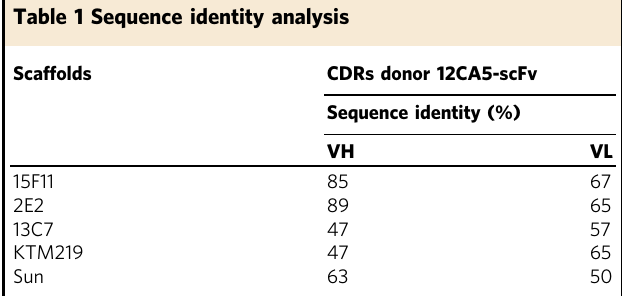
and χ HA in living cells 15 F 11 2 E 2